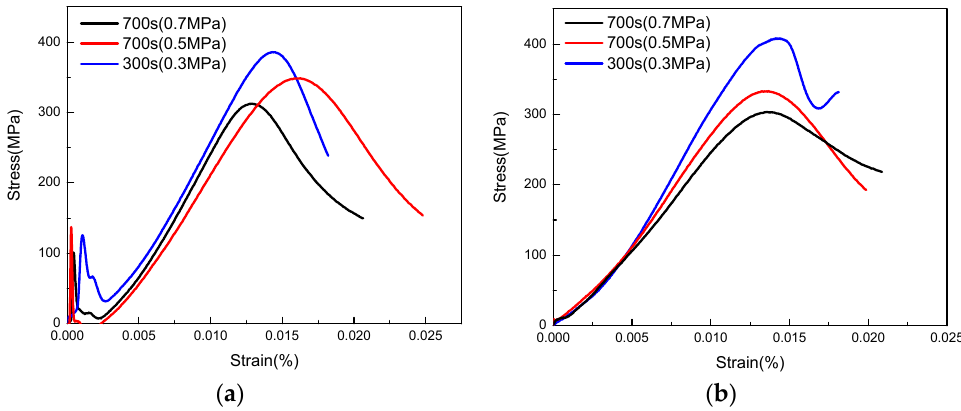
Figure 11. Stress-strain curves of two materials under high-speed impact. ( a ) Unidirectional prepreg composites. ( b ) Plain weave prepreg composite.